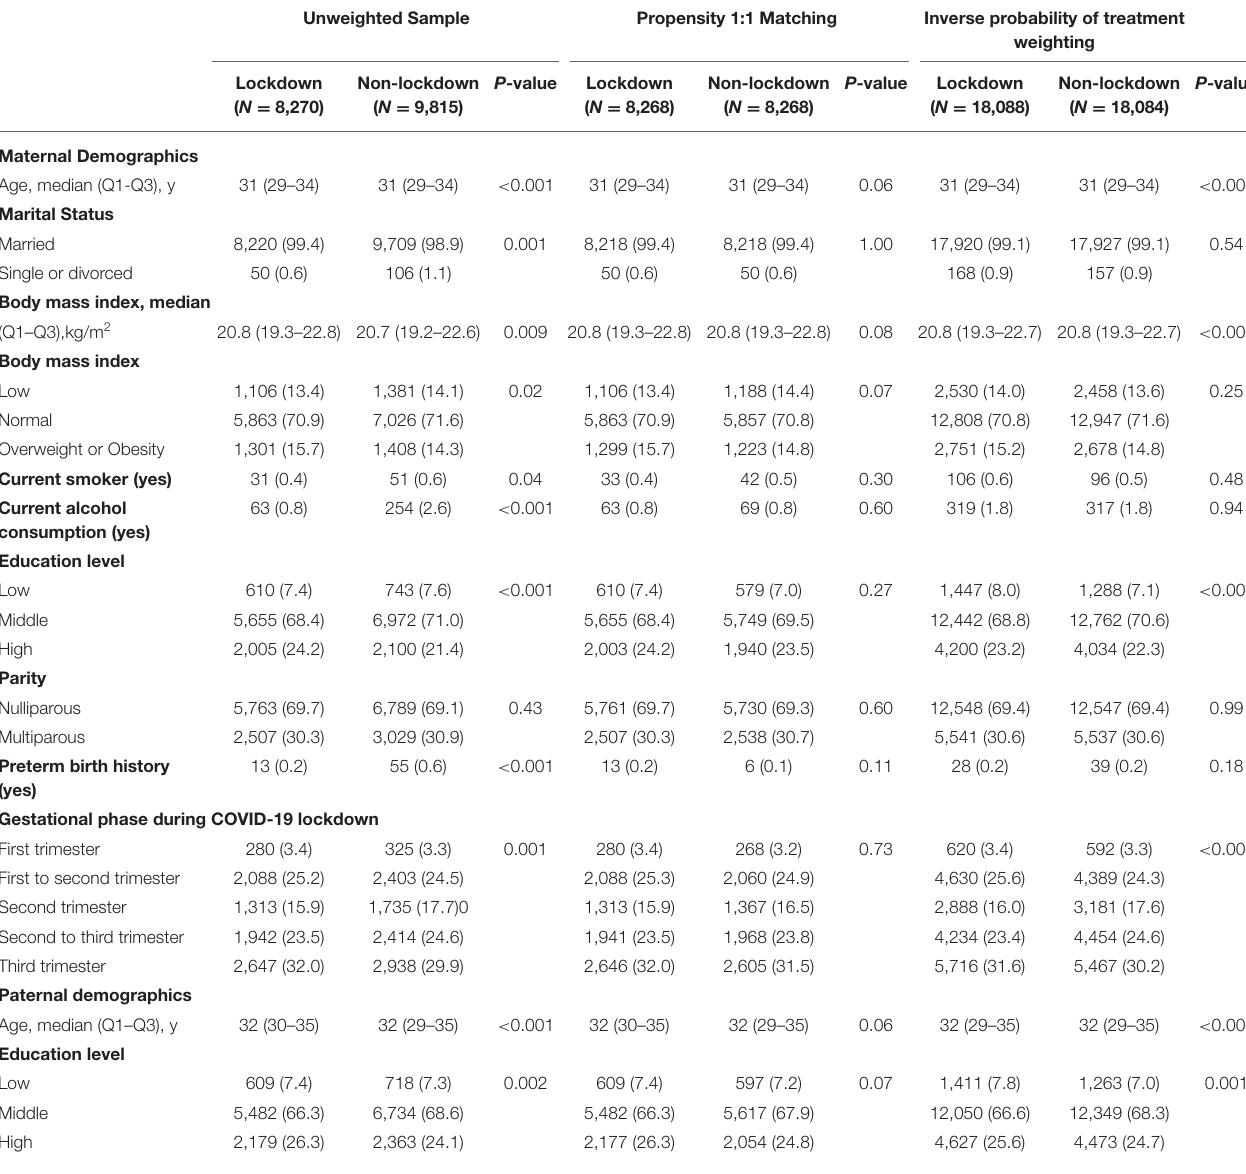
TABLE 1 | Baseline characteristics total sample, unweighted sample, propensity score-matched sample, and inverse probability of treatment-weighted sample. Unweighted Sample Propensity 1:1